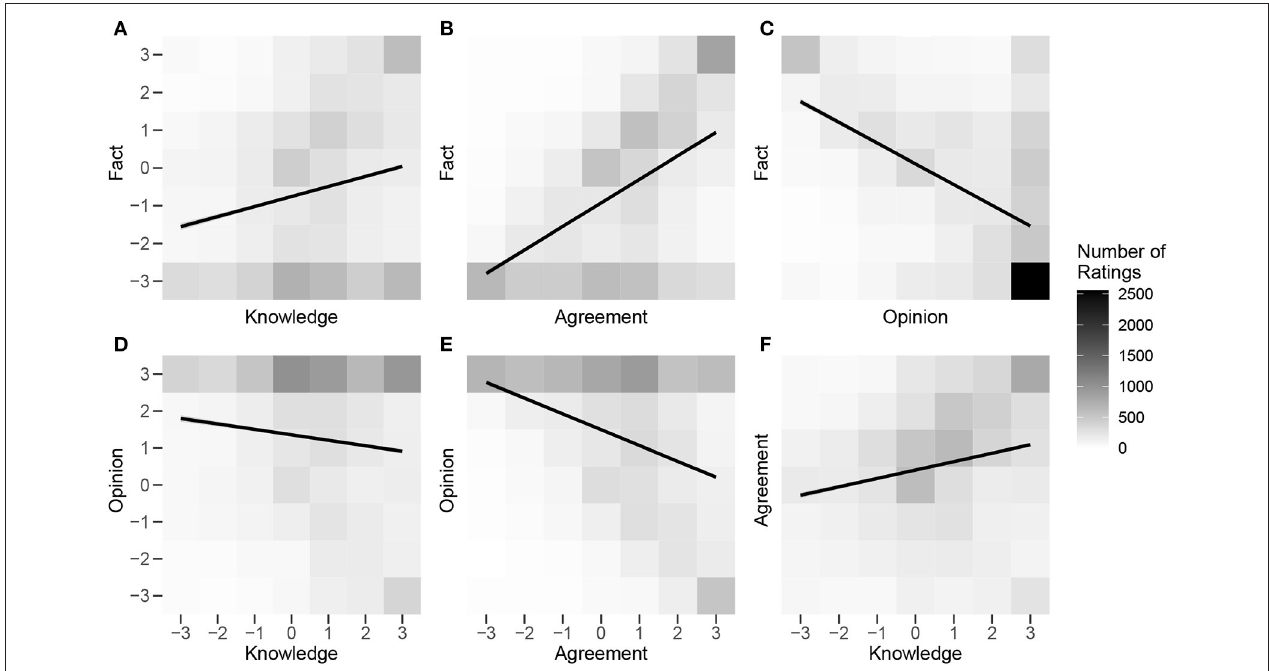
FIGURE 3 | Two-dimensional histograms of pairwise associations between Fact × Knowledge (A) , Fact × Agreement (B) , Fact × Opinion (C) , Opinion × Knowledge (D) , Opinion × Agreement (E) , and Agreement × Knowledge (F) rating scales for Study 1. The shading of each cell represents the number of paired ratings falling into that category, with darker cells representing more ratings. Scores of − 3 and +3 correspond to the labels “This is not a fact” and “This is a fact” for the Fact rating scale; “This is not an opinion” and “This is an opinion” for the Opinion rating scale; “I know very little about this topic” and “I know a lot about this topic” for the Knowledge rating scale; and “I completely disagree” and “I completely agree” for the Agreement rating scale. Intermediate scale points were not verbally